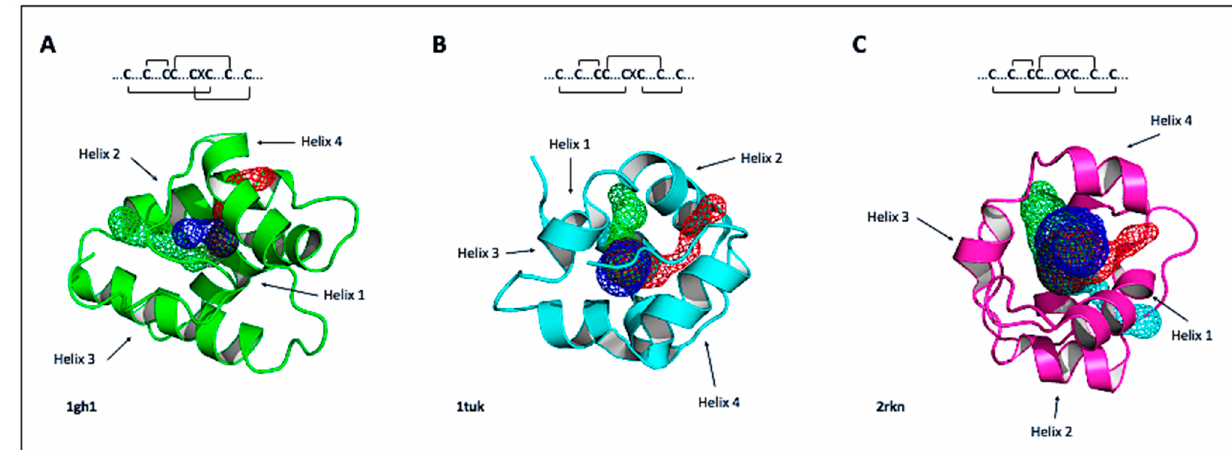
Figure 2. Three-dimensional representation of nsLTPs: ( A ) 1GH1 (nsLTP type I, in green), ( B ) 1TUK (nsLTP type II, in cyan) and ( C ) 2RKN (nsLTP type IV, in magenta). At the top is the disulfide bridge pattern of the respective structures, where C represents cysteine and X any amino acid. The black arrows indicate the four helices present in the nsLTP structures. The mesh spheres (blue, green and red) in the center of the structures represent the hydrophobic pocket identified by Caver 3.0 PyMol plugin (https://github.com/loschmidt/caver-pymol-plugin/blob/master/COPYING), public license [20] and visualized in PyMOL.